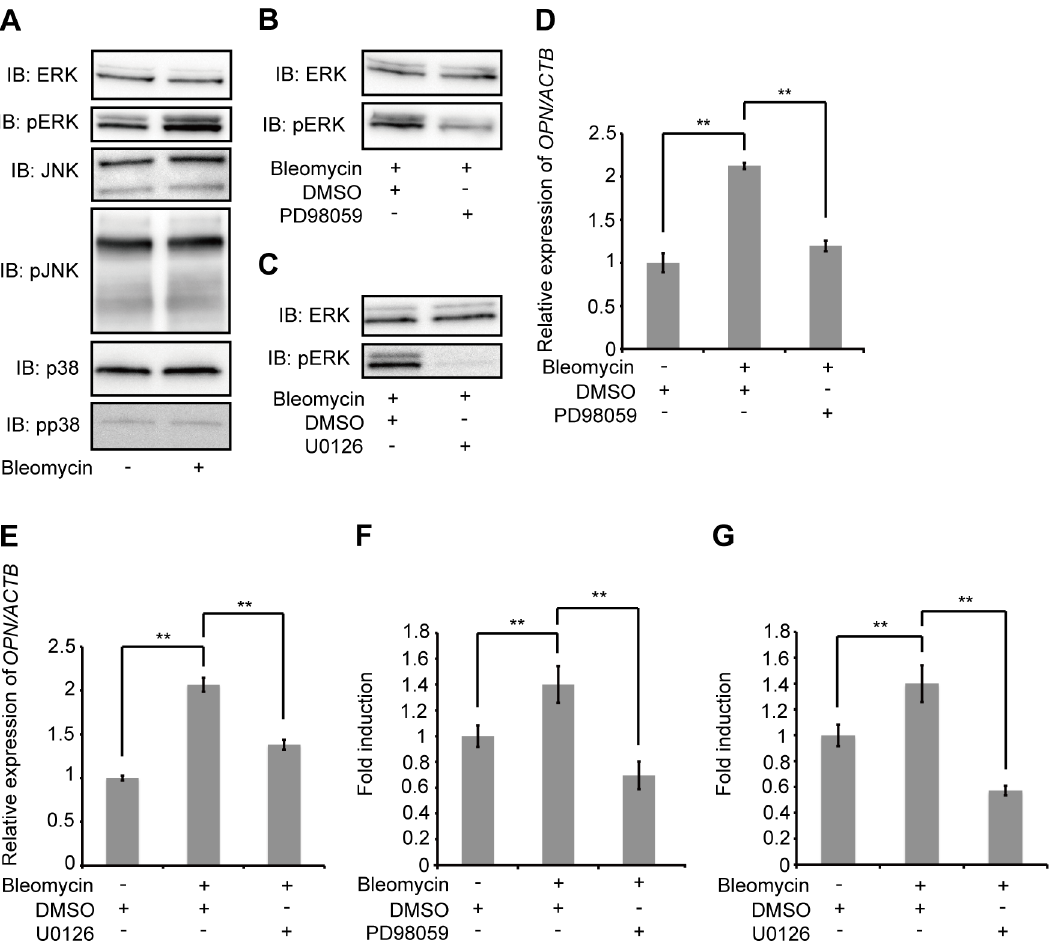
Figure 2. Molecular mechanism of OPN induction after exposure to bleomycin. (A) A549 were exposed to 10 m g/mL bleomycin or PBS for 24 h. Western blotting was used to detect phospho-specific ERK1/2, ERK1/2, phospho-specific SAPK/JNK, SAPK/JNK, phospho-specific p38 MAPK and p38 MAPK. (B) A549 were pretreated with PD98059 (50 m M) or DMSO for 1 h, and subsequently exposed to 10 m g/mL bleomycin for 48 h. Western blotting was used to detect phospho-specific ERK1/2 and ERK1/2. (C) A549 were pretreated with U0126 (50 m M) or DMSO for 1 h, and subsequently exposed to 10 m g/mL bleomycin for 48 h. Western blotting was used to detect phospho-specific ERK1/2 and ERK1/2. (D) A549 were pretreated with PD98059 (50 m M) or DMSO for 1 h, and subsequently exposed to 10 m g/mL bleomycin or PBS for 48 h. OPN mRNA was assessed by qRT-PCR. (E) A549 were pretreated with U0126 (50 m M) or DMSO for 1 h, and subsequently exposed to 10 m g/mL bleomycin or PBS for 48 h. OPN mRNA was assessed by qRT-PCR. (F) A549 were pretreated with PD98059 (50 m M) or DMSO for 1 h, and subsequently exposed to 10 m g/mL bleomycin or PBS for 48 h. OPN concentrations in cell culture media were determined by ELISA. (G) A549 were pretreated with U0126 (50 m M) or DMSO for 1 h, and subsequently exposed to 10 m g/mL bleomycin or PBS for 48 h. OPN concentrations in cell culture media were determined by ELISA. Data are presented as mean 6 S.E. *, P , 0.05; **, P , 0.01.